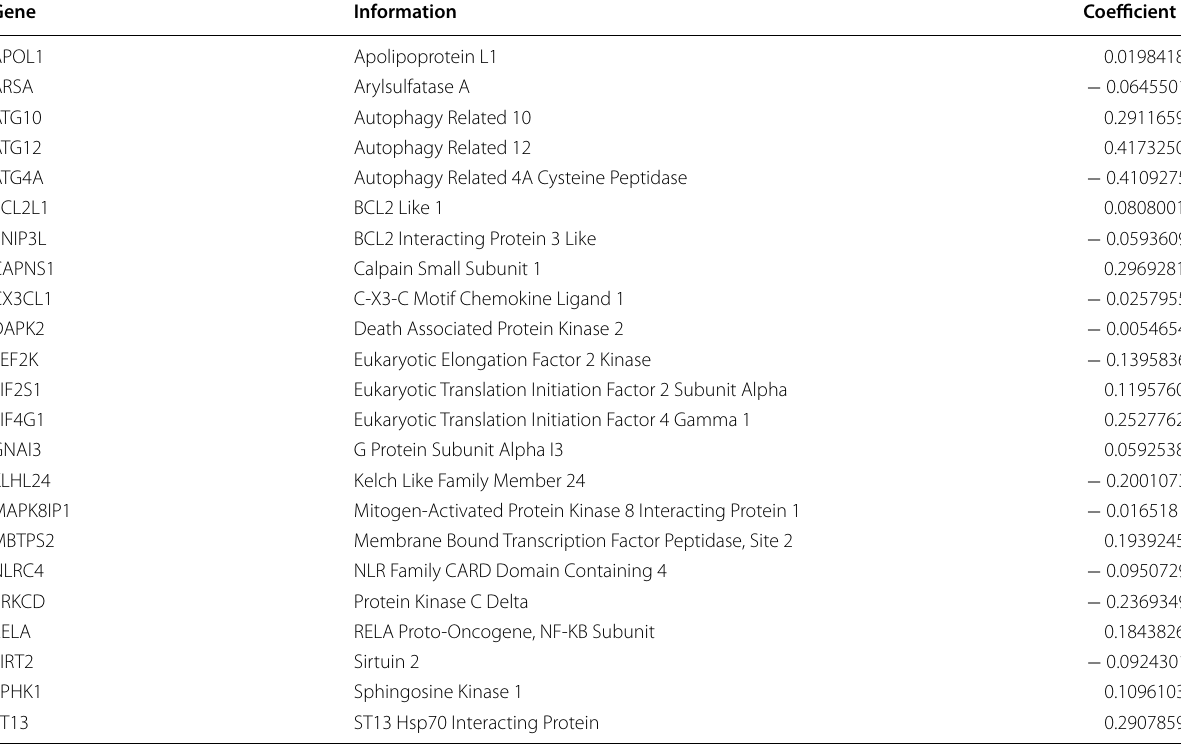
Table 1 List of genes included in the risk signature Gene Information